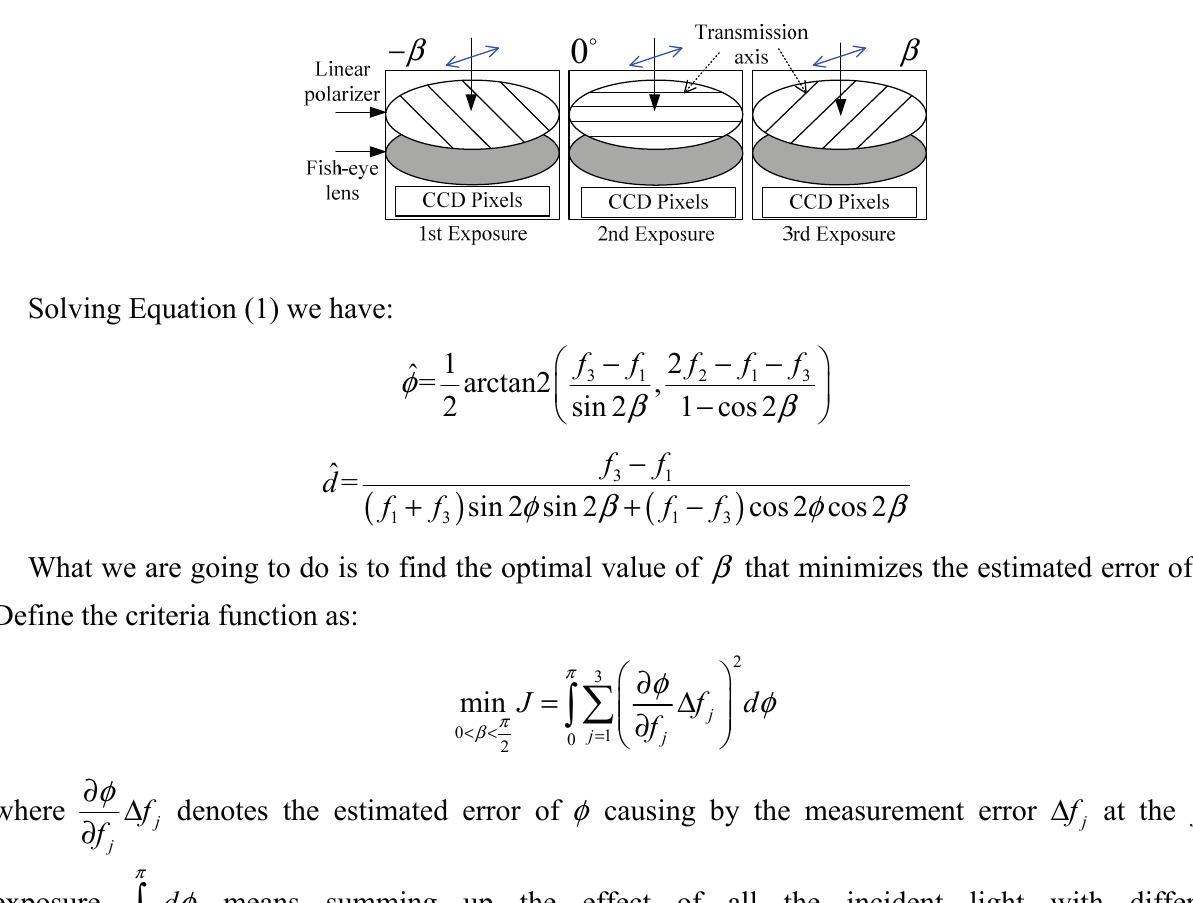
Figure 2. Schematic of the alignments of the